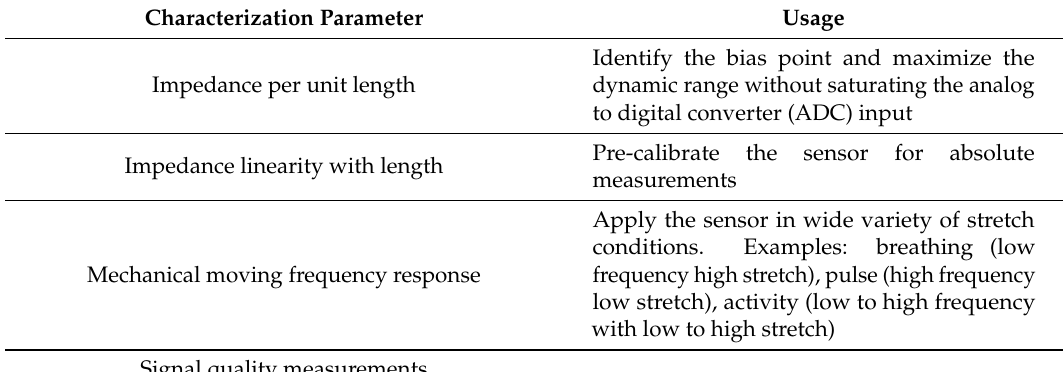
Table 1. Characterisation measures and intended use case